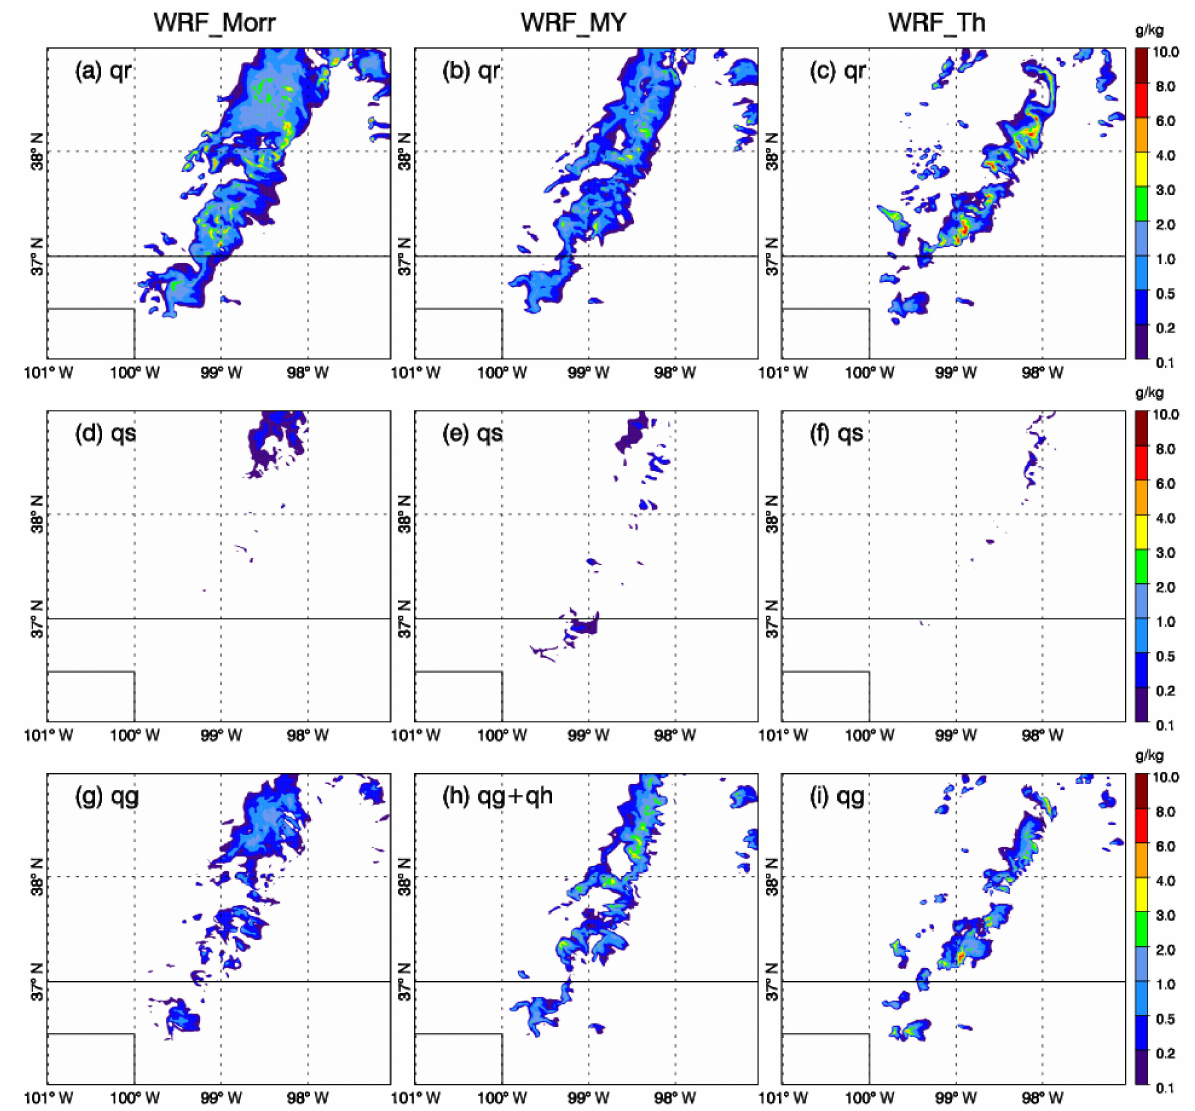
Figure 7. Mixing ratio of rainwater ( a – c ), snow ( d – f ), and graupel and/or hail ( g – i ) for WRF_Morr, WRF_MY, and WRF_Th, respectively. All plots are for the fields at 2345 UTC 29 May 2018 at 3 km